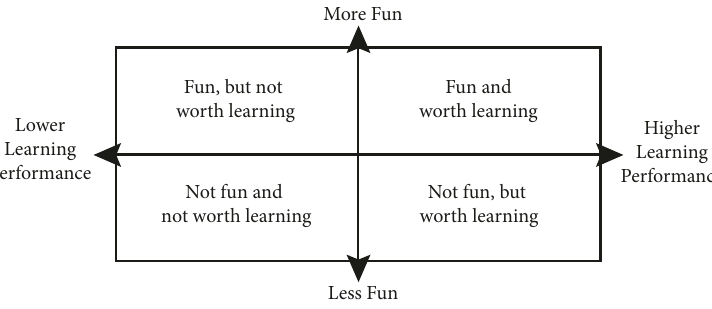
Figure 2: Gameplay Experience Evaluation for Learning Performance